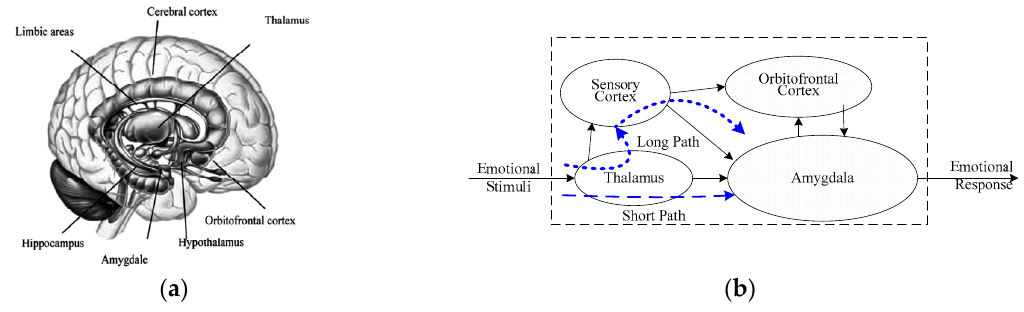
Figure 1. Limbic system and emotion circuits in the brain. ( a ) Limbic system; ( b ) emotion circuits, modified from reference [13].